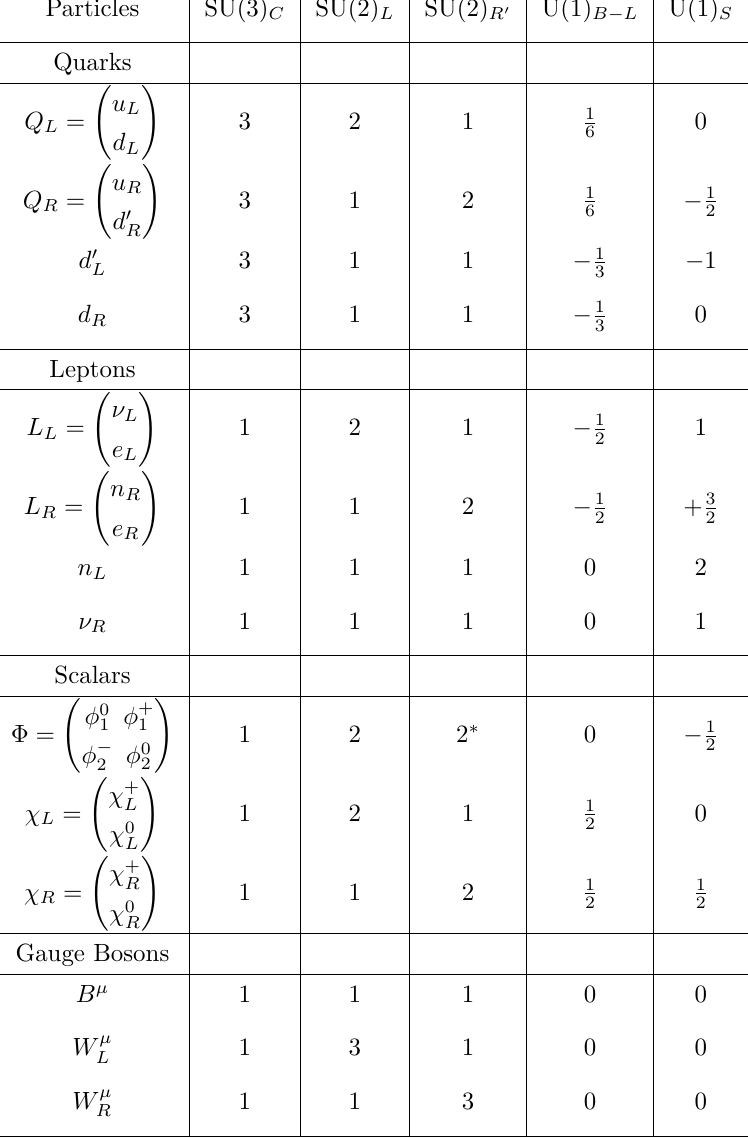
Table 1 . Particle content of ALRM together with their quantum numbers under SU(3) C ⊗ SU(2) L